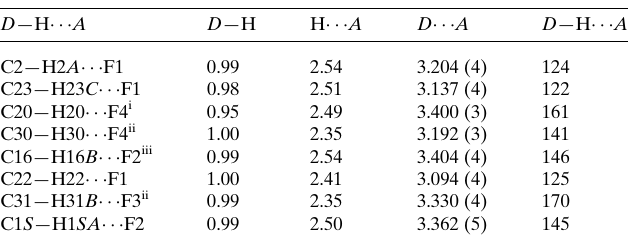
Table 1 Hydrogen-bond geometry (A˚ , (cid:4) ).